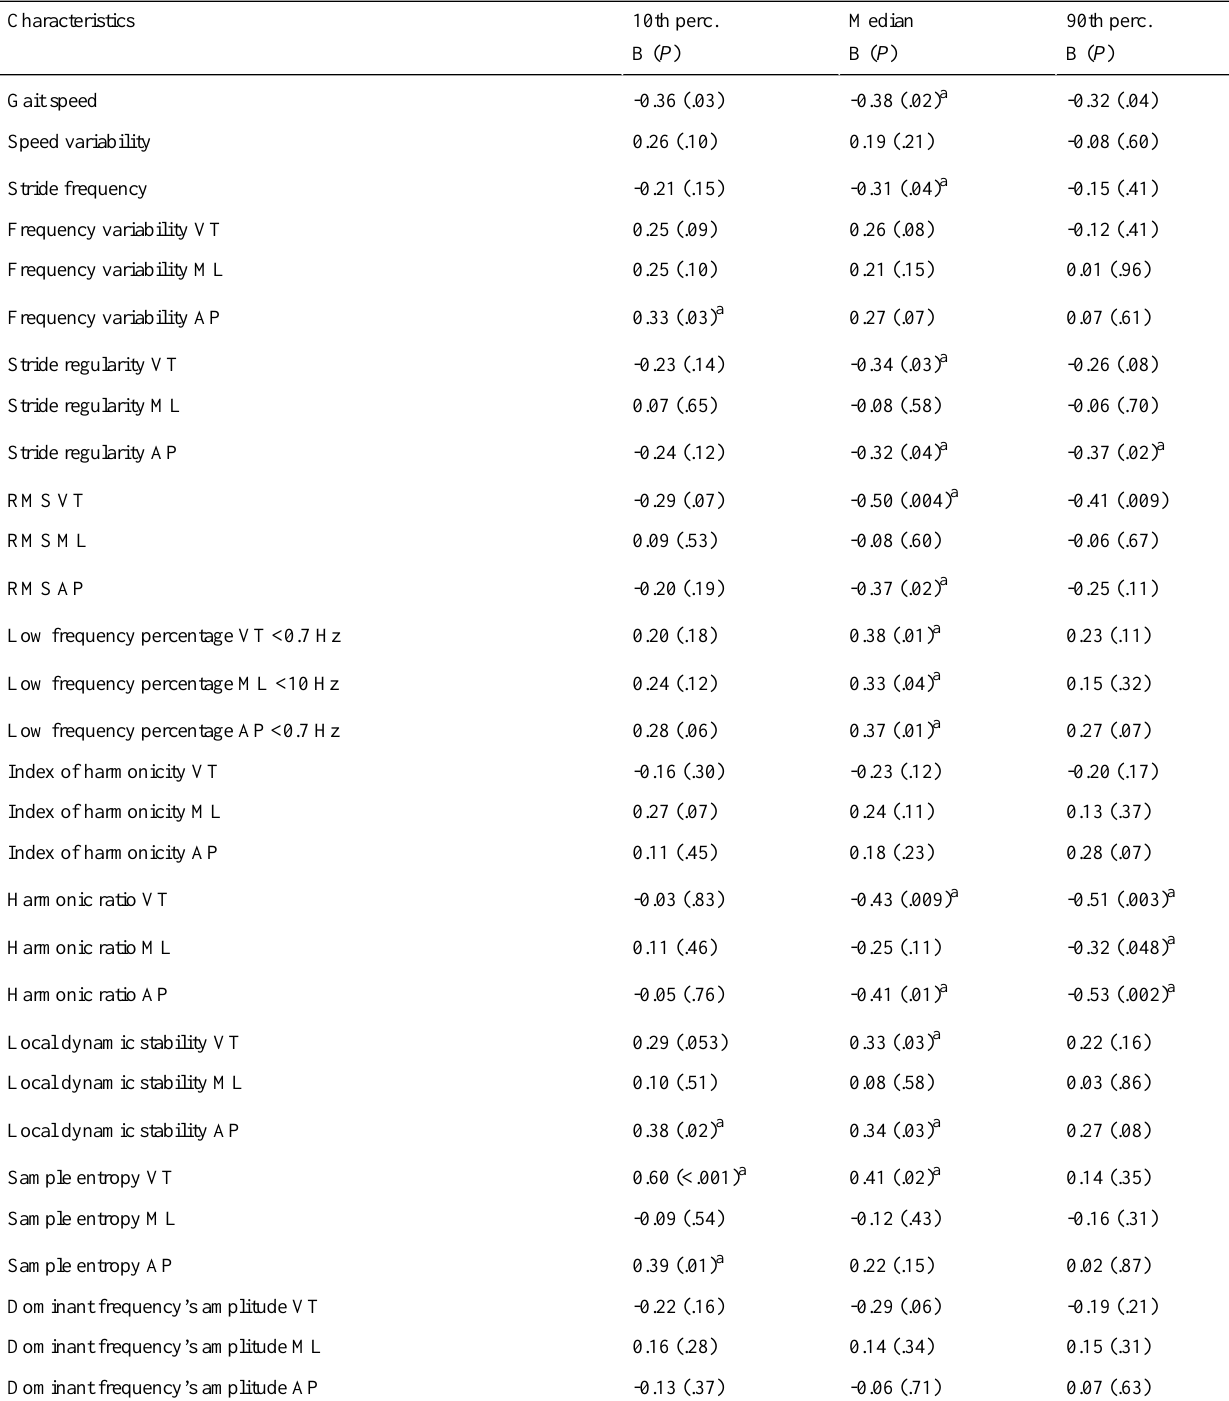
Table 2. Univariate logistic regression of gait characteristics’ 10th, 50th, and 90th percentile values, with future falls (B values [ P values] are based on z -transformed data).